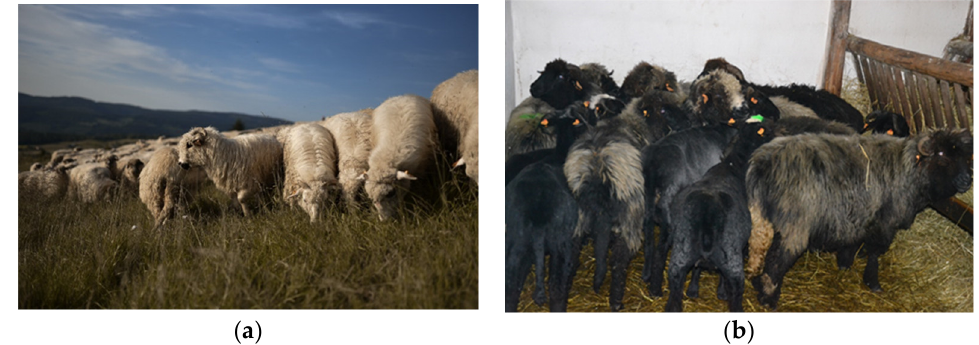
Figure 1. Polish Mountain Sheep; ( a ) typical white variety in the mountain pasture; ( b ) black variety during shearing.